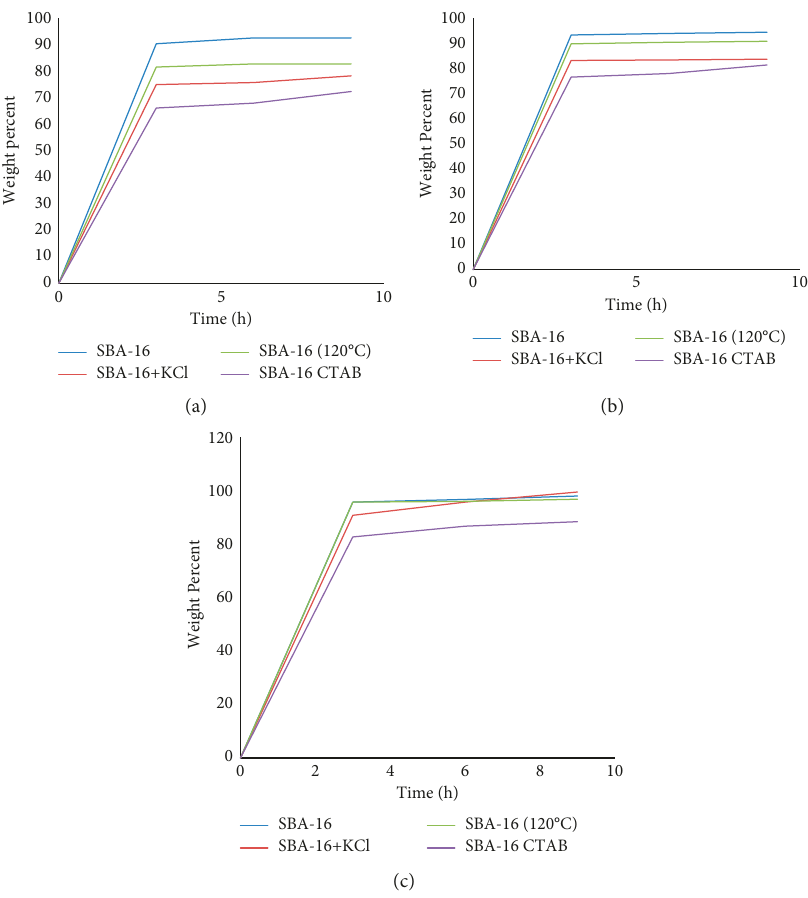
Figure 6: Drug loading of different IBU concentrations on mesoporous silica samples. (a) Loading of 0.015g IBU. (b) Loading of 0.025g IBU. (c) Loading of 0.035 g